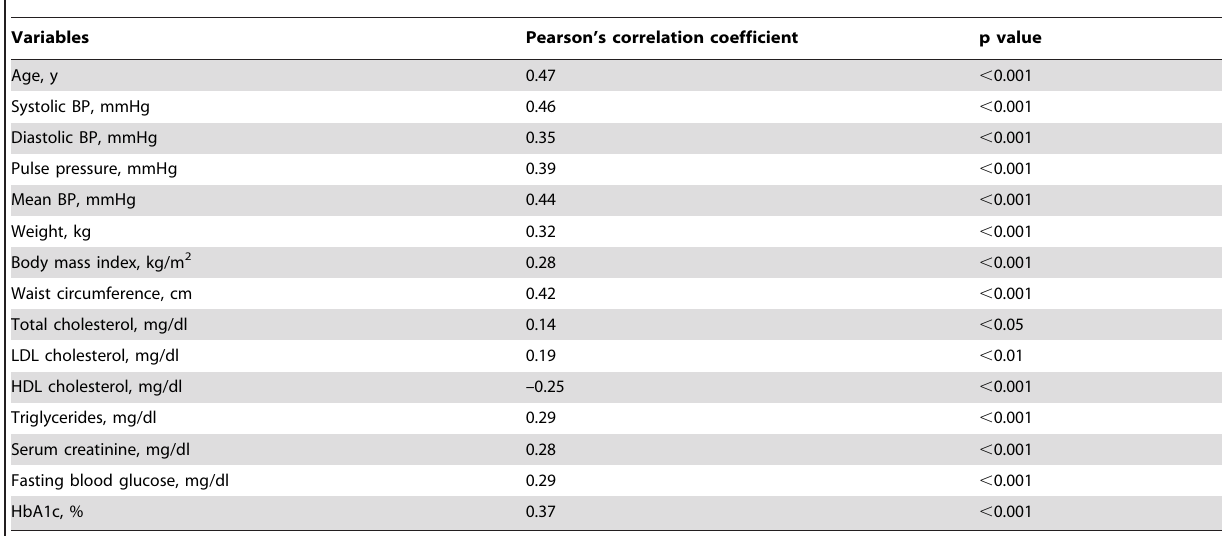
Table 3. Covariates of PWV in univariate analyses in the total study population.